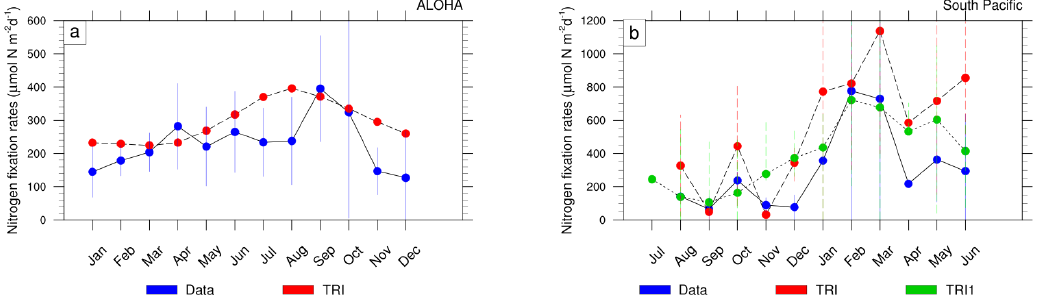
Figure 7. (a) Depth-integrated (0 to 125m) rates of N 2 fixation (µmolNm − 2 d − 1 ) at ALOHA for the data (blue) and TRI simulation (red). (b) Depth-integrated (from 0 to 150m) rates of N 2 fixation (µmolNm − 2 d − 1 ) in the South Pacific (red box, Fig. 1c) in the data (blue) and in the TRI simulation (red). The blue curve is the average of all the model points inside the South Pacific zone (red box, Fig. 1c), whereas the green curve corresponds to the average of the model points where data are available.